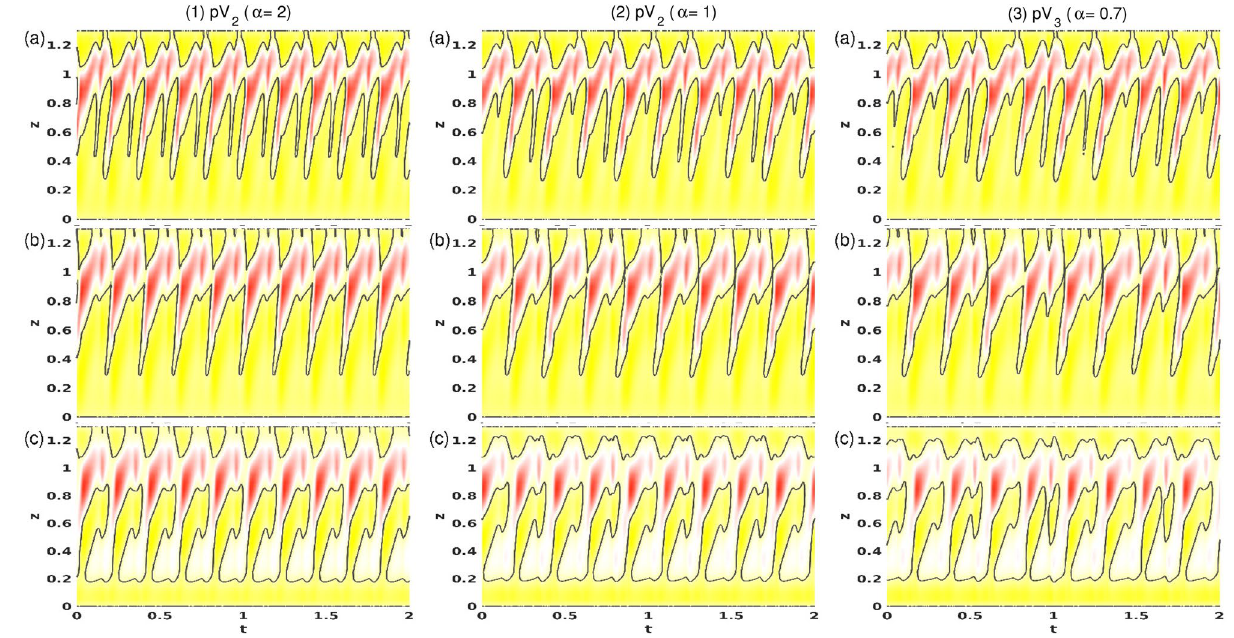
2 , ( 2 ) at α 1 , and for pV 3 at ( 3 ) α 0.7 . Visualizations = = = d / 4 , (b) r d / 2 , and (b) r 3 d / 4 . Red (dark gray) and = = =